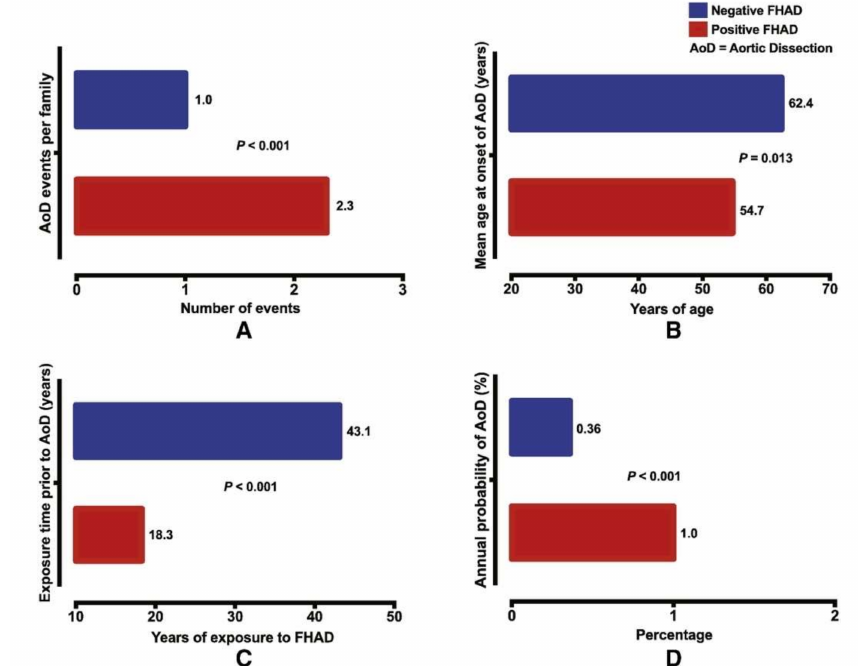
Figure 3. Positive family history of aortic dissection (FHAD) significantly increases the risk of developing a new dissection in una ff ected family members, with ( A ) higher number of dissection events; ( B ) a younger age at dissection; ( C ) shorter duration of exposure prior to dissection; and ( D ) higher annual probability of aortic dissection. © 2020 by Elsevier.